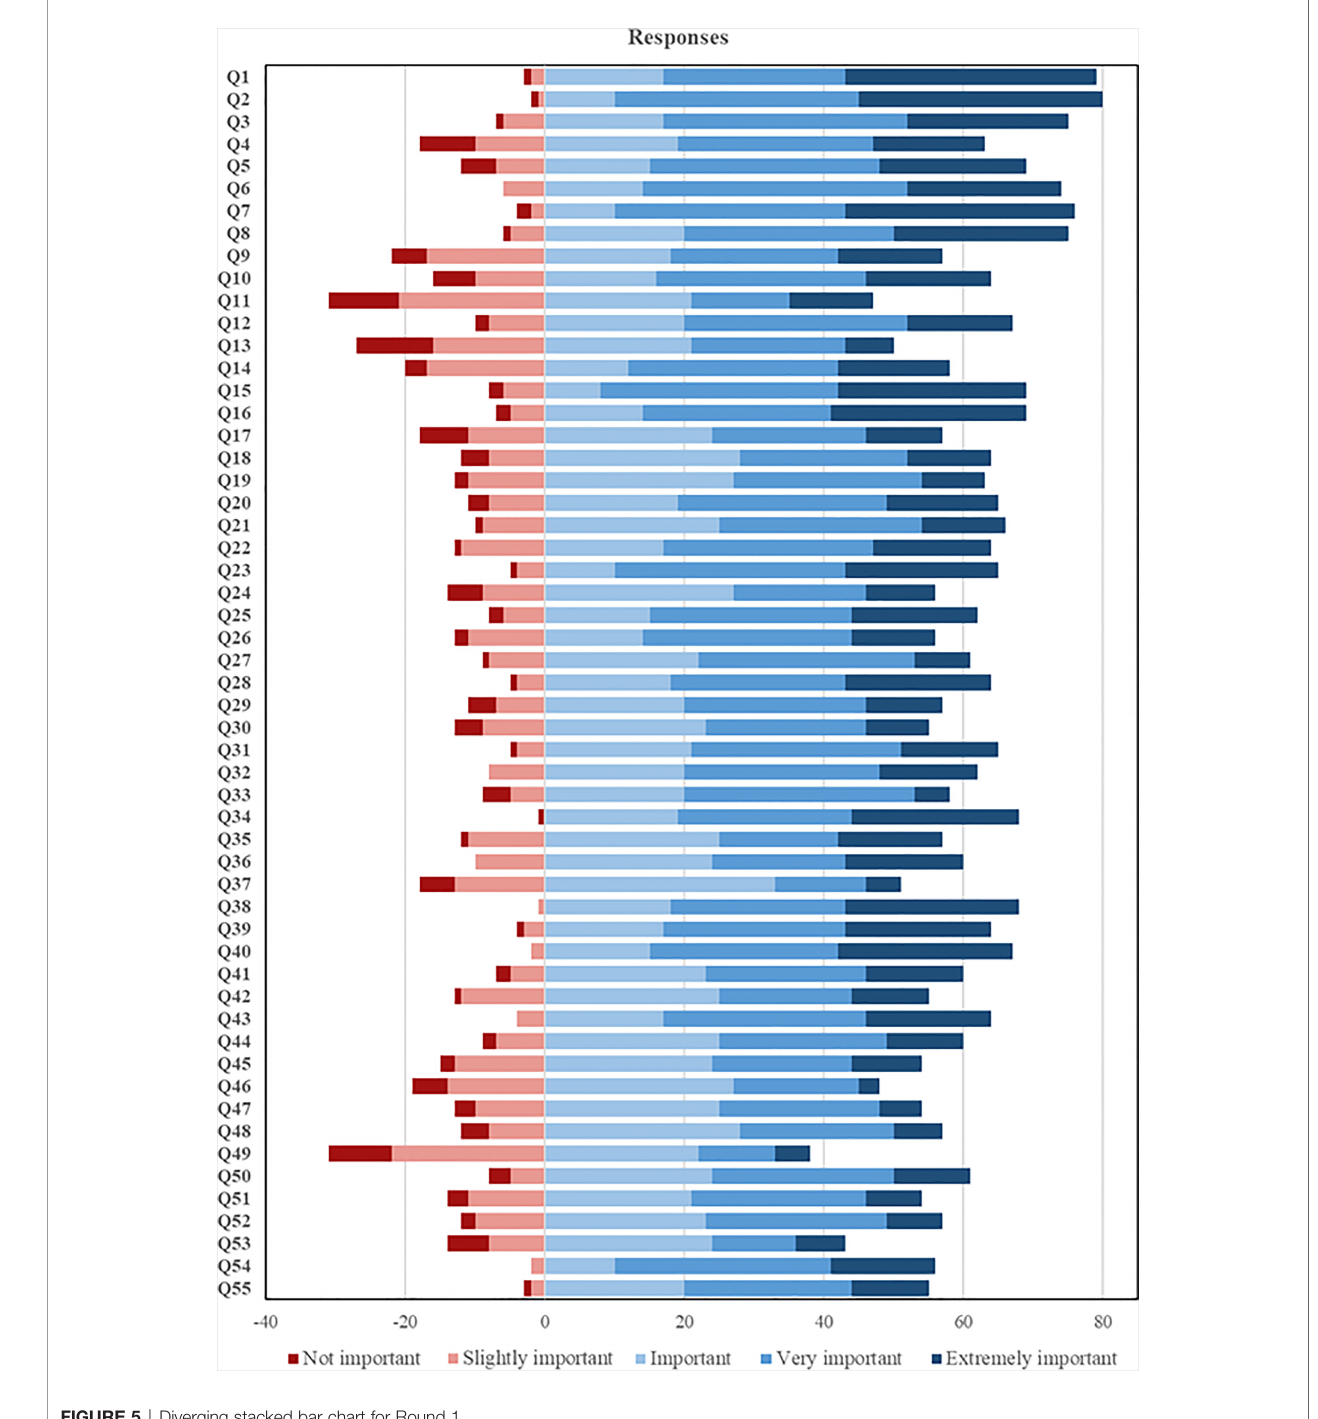
FIGURE 5 | Diverging stacked bar chart for Round